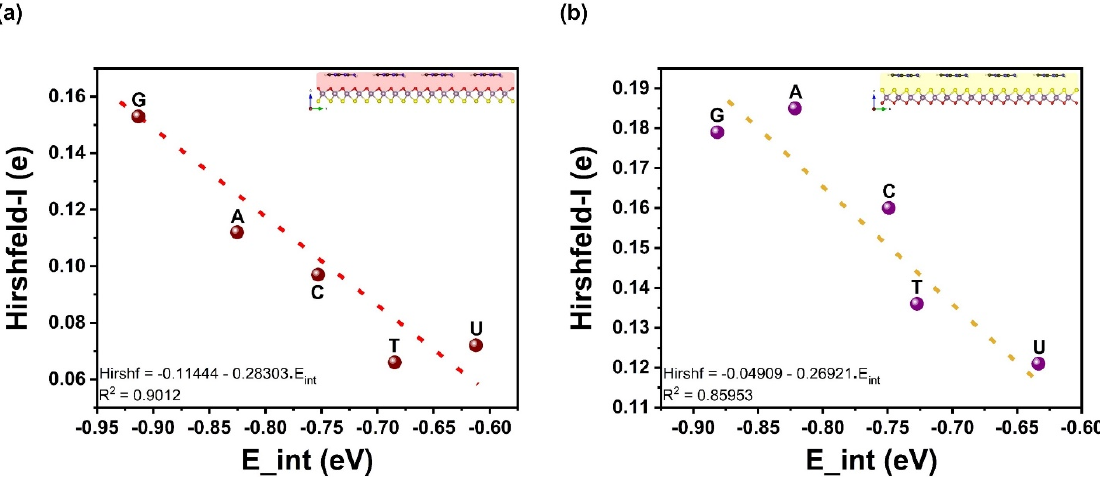
Figure 6. Hirshfeld-I electronic charge as function of interaction energy of the nucleobases molecules on the Janus MoOS monolayer facets, ( a ) on O layer, ( b ) on S layer, respectively.